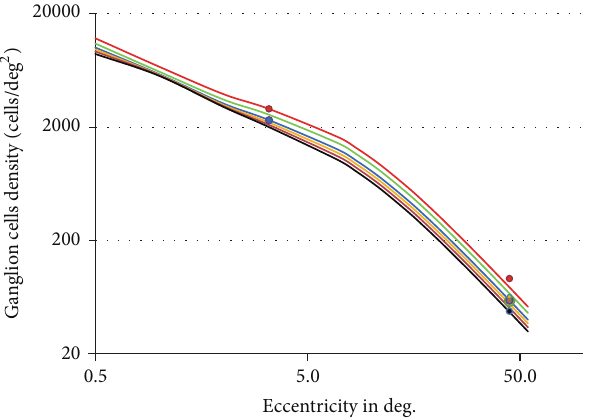
Figure1:Ganglioncellsdensityasafunctionofeccentricityandage. Solid curves represent the proposed model (15), and circles are taken from experimental data [44, 46]. Red: 20 years; green: 40 years; blue: 60 years; yellow: 70 years; brown: 80 years; black: 90 years.